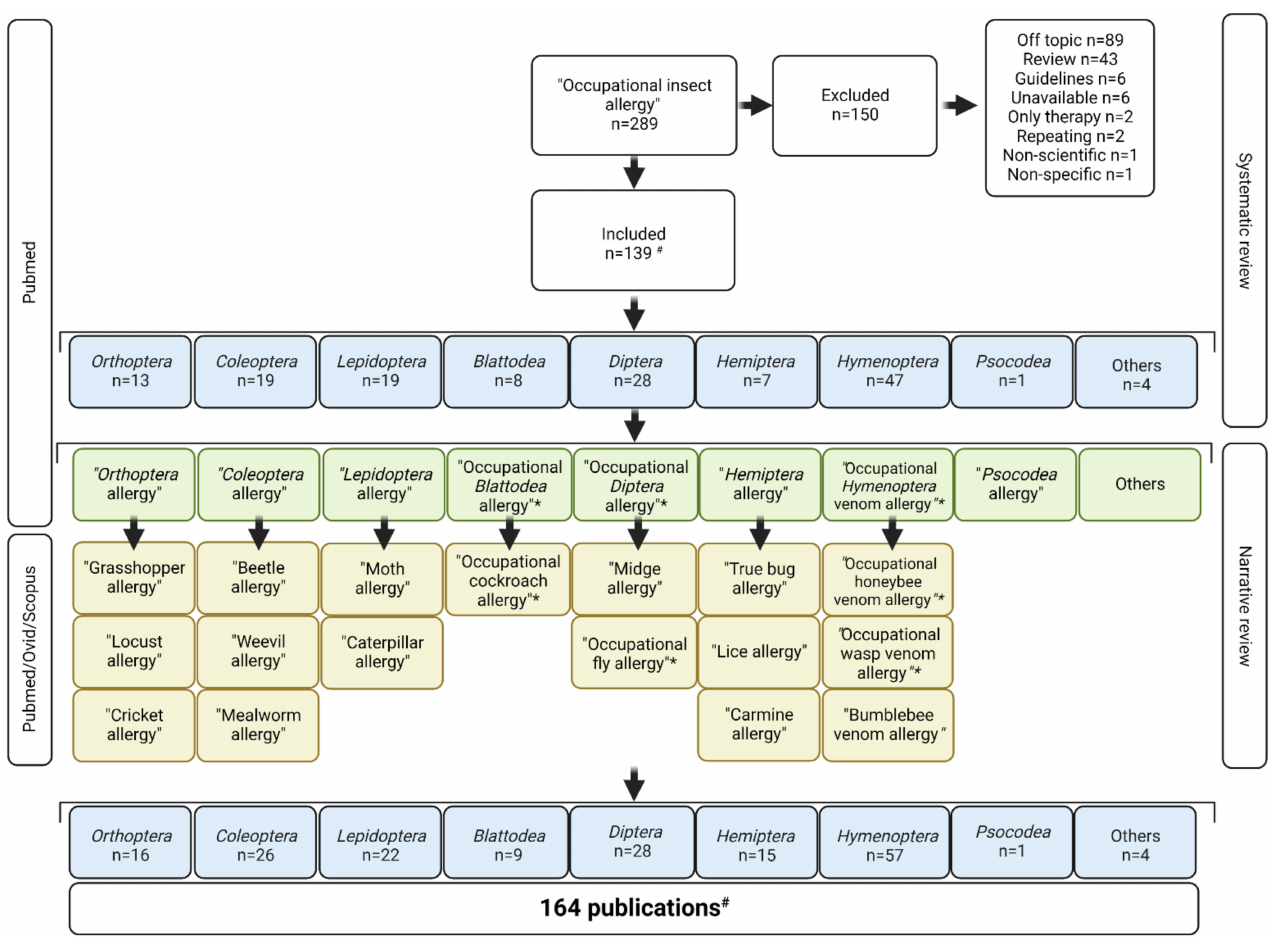
Figure 1. Overview of literature search. * if a search term obtained >1000 results, the search was narrowed to occupational allergies only. # some publications describe insects of multiple phyloge- netic